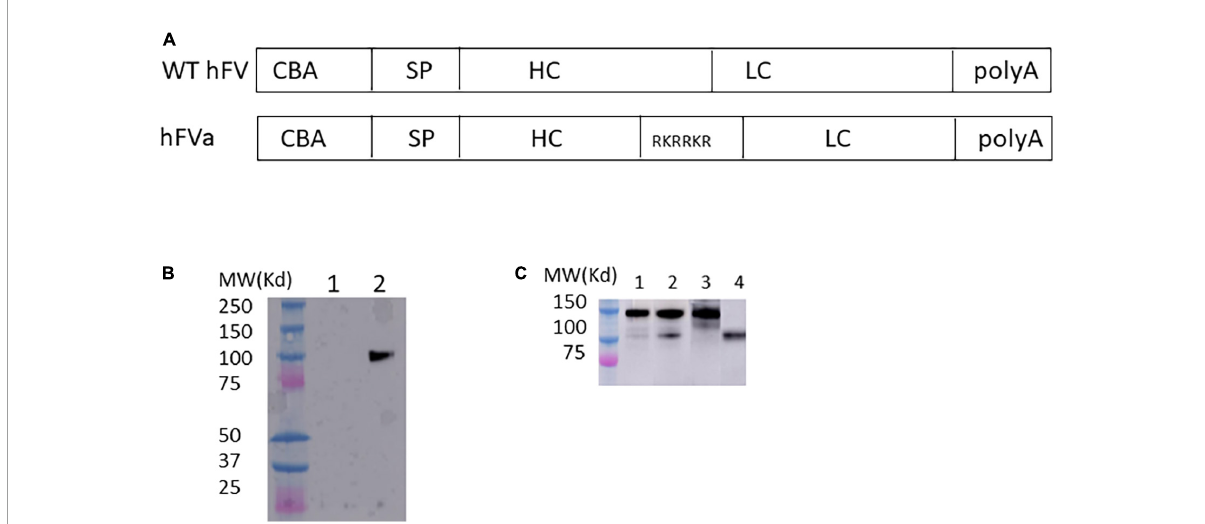
FIGURE1 FVa formation in transfected HEK 293 cells. (A) Diagram of human FVa construct for in vitro expression in HEK 293 cells. CBA, chicken beta actin promoter; SP, signal peptide; HC, heavy chain; LC, light chain. (B) Plasmids of hFVa driven by CBA promoter were transfected in HEK 293 cells; 3 days later, the supernatant was harvested for detection of hFVa with the GMA-044 detection antibody, which specifically recognizes the hFV HC. Lane 1: green fluorescent protein (GFP); lane 2: hFVa. (C) Plasmids of full length FV (“hFV”) and BDD-hFVa (“hFVa”) were transfected in HEK293 cells; 3 days later, the supernatant was harvested. Thrombin at a final concentration of 10 U/ml was added to the supernatant; 10 and 30 min later, Western blot was performed using anti-hFVa as the detection antibody for light chain of FV. Lane 1: hFV + thrombin 10 min; Lane